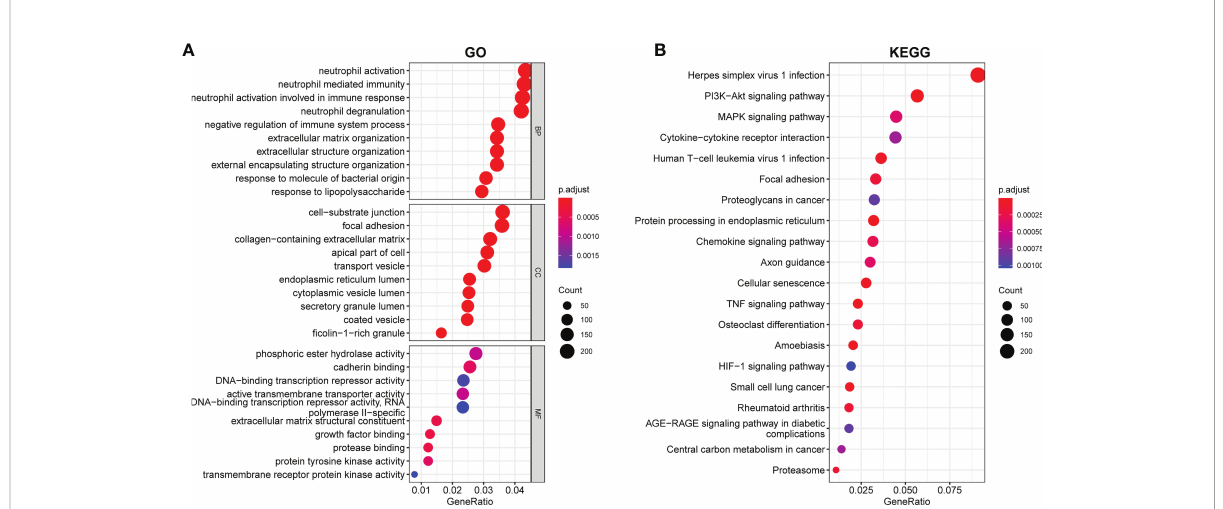
FIGURE 2 Enriched items in GO and KEGG analyses using DEGs. (A) Enriched items in GO analysis. (B) Enriched items in KEGG pathway analysis. GO, Gene Ontology; BP, Biological process; CC, Cellular component; MF, Molecular function; KEGG, Kyoto Encyclopedia of Genes and